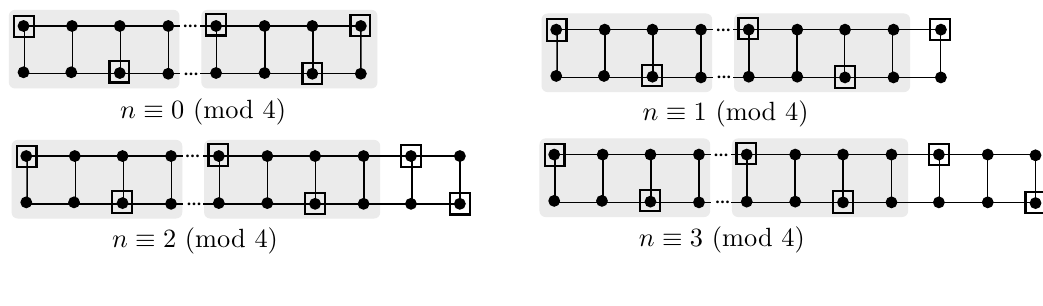
Figure 2: Eviction sets on 2